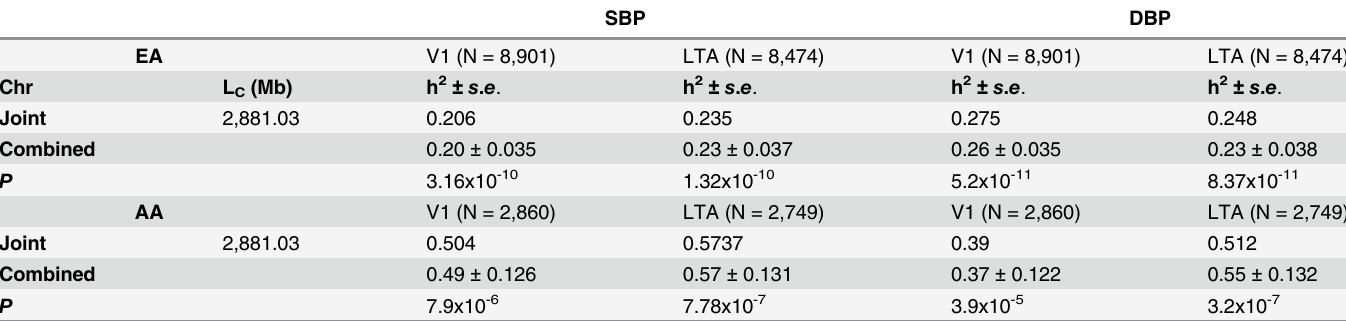
Table 2. Proportion of the genetic variance explained by chromosome (joint) and the whole genome (combined) using 8,901 EA and 2,860 AA indi- viduals. The trait analyzed is first-visit SBP and DBP and long-term average (LTA) SBP and DBP respectively using genotyped and imputed SNPs. The her- itability (h 2 ), its standard error (se) and significance value (P) are shown.